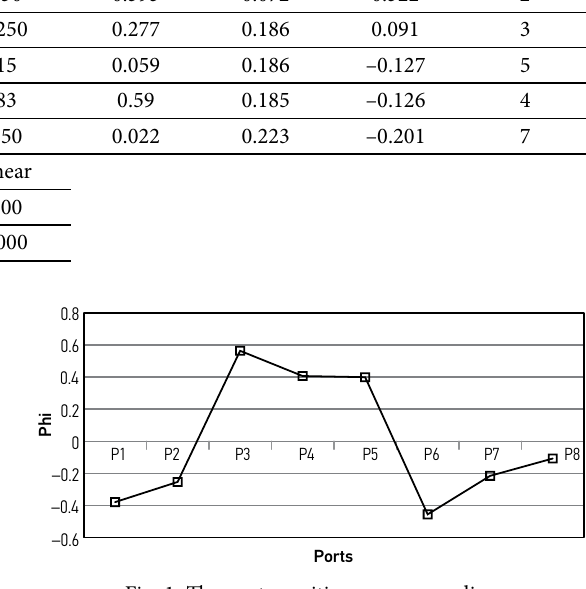
Fig. 1. The ports positions corresponding to the PROMETHEE net flows determined according to the A1 set sub-criteria values